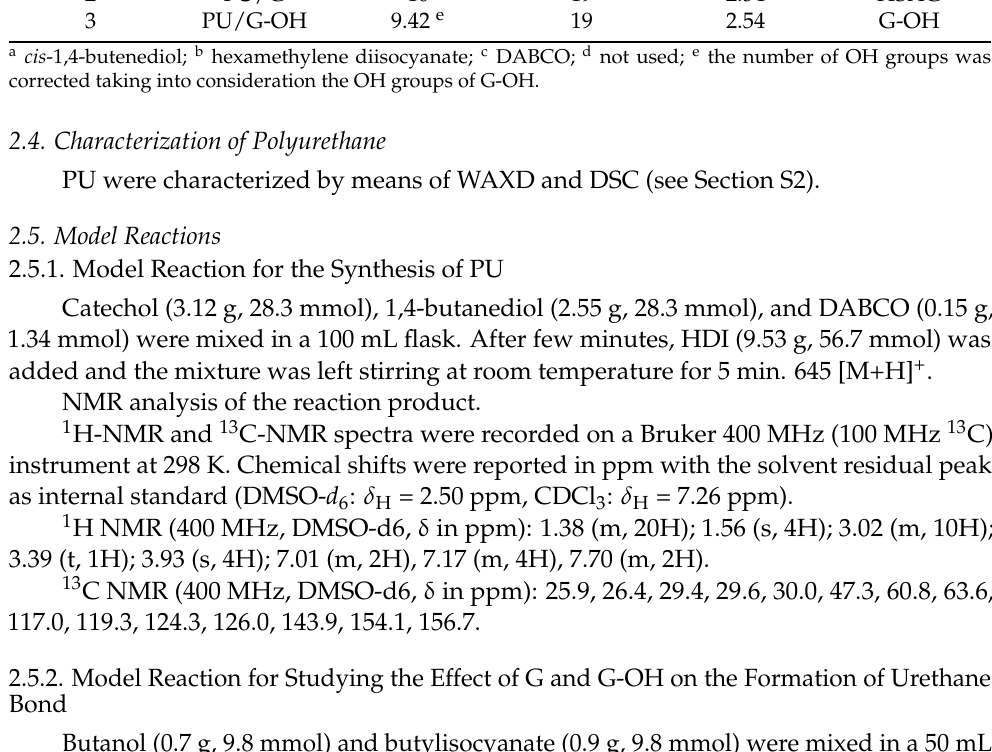
Table 1. Synthesis of polyurethanes: formulations, recipes and reaction conditions. Run PU Sample Diol a Isocyanate b Catalyst c Filler [g] [g] [mg] (3 %w) 1 PU 10 19 2.54 n.u. d PU/G 10 19